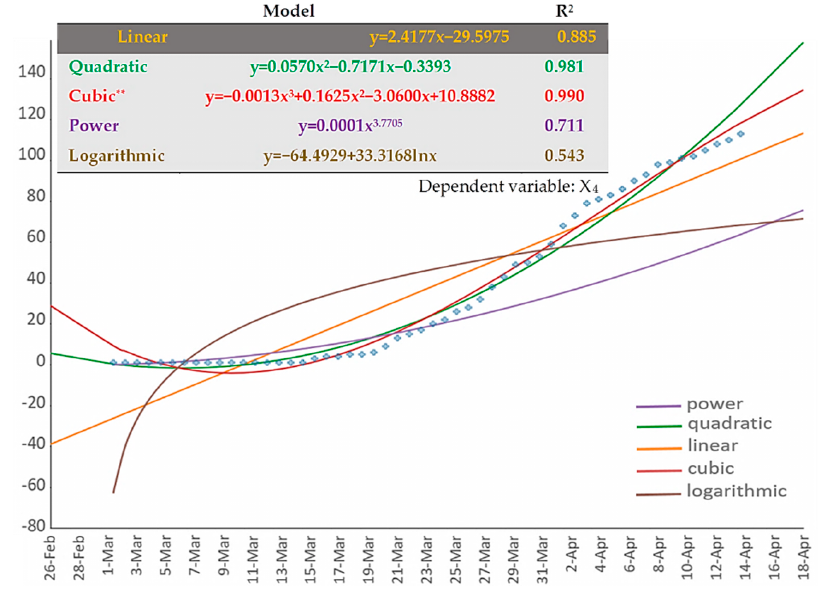
Figure 7. The available types of fitting curves applied to the cumulative COVID ‐ 19 death curve (variable X 4 ) of Greece. Time ‐ series data of the variable are shown in dots.